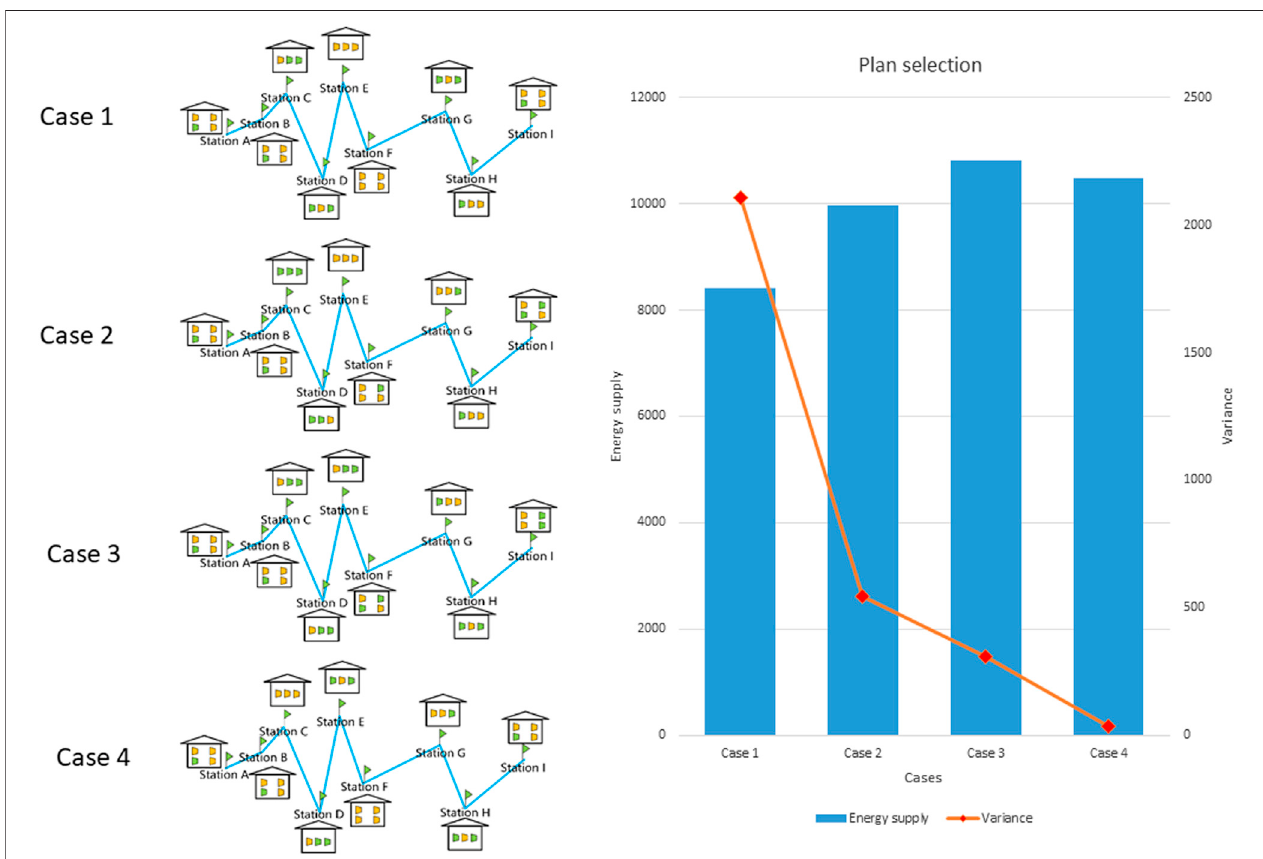
FIGURE 11 | Plan selection on